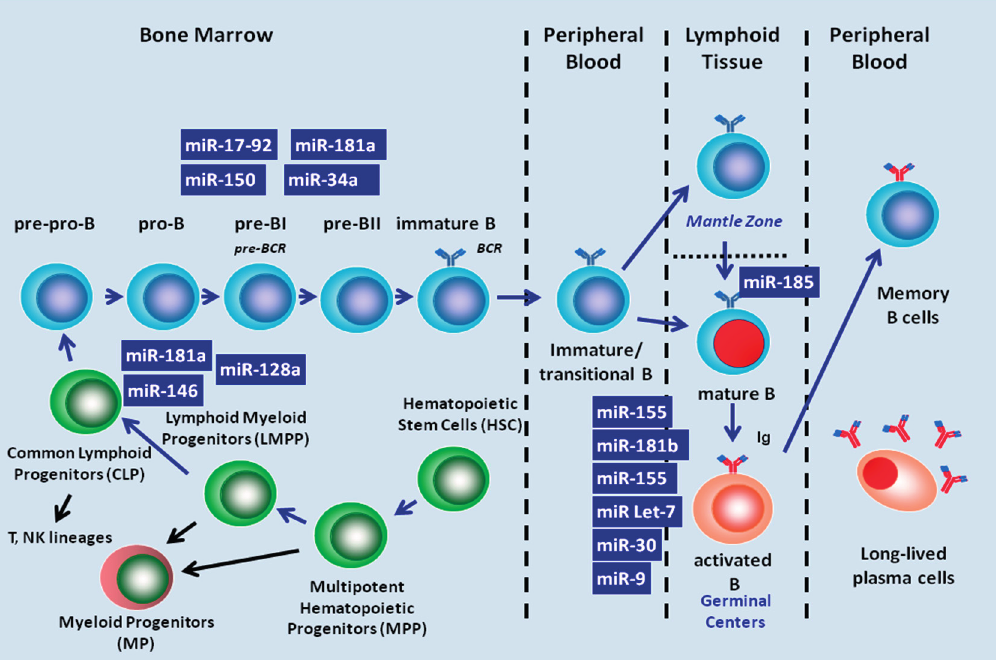
Figure 2. MiRNAs Involved in the regulation of B-cell development from common lymphoid progenitor cell to produce memory and plasma